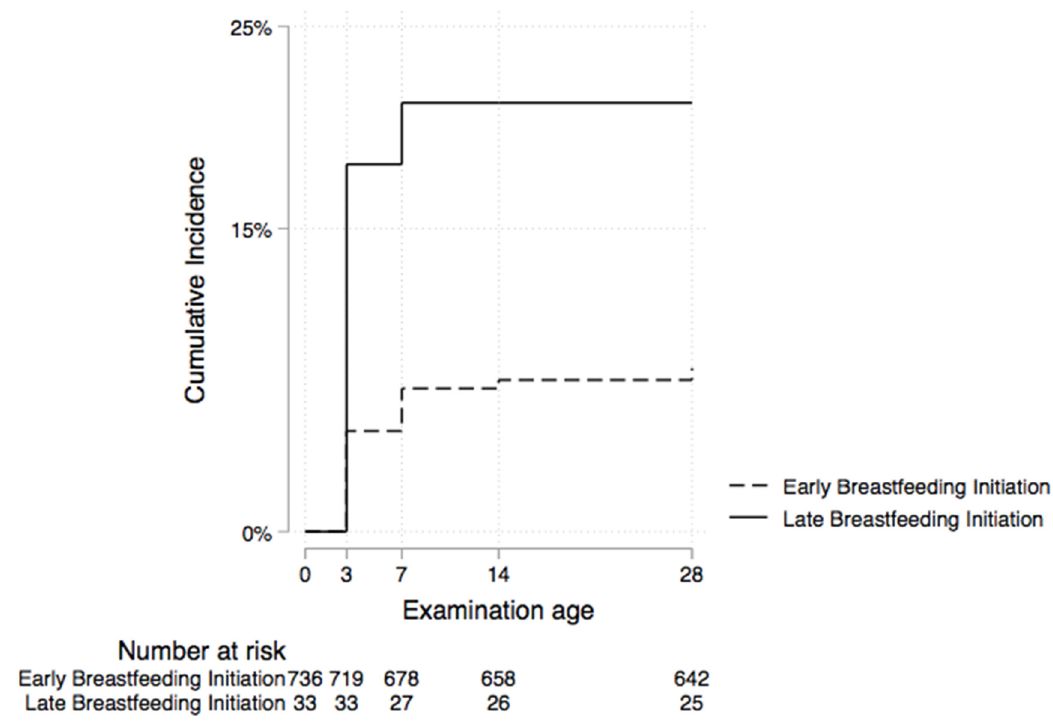
Figure 3. Rate of omphalitis by breastfeeding initiation status at three study sites in central Uganda. Table 3. Factors associated with omphalitis among neonates at the three study sites in central Uganda.